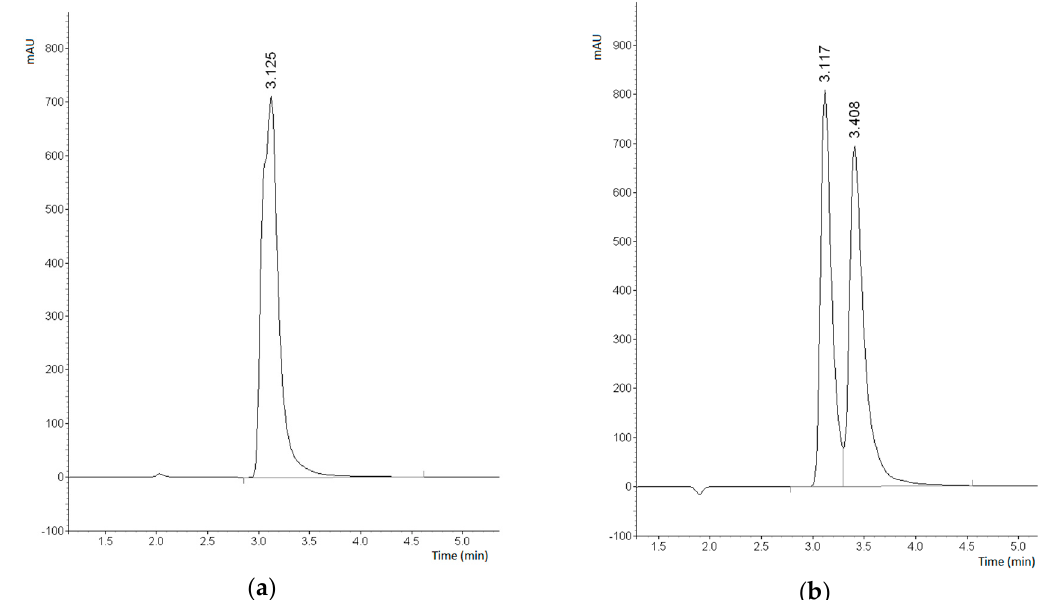
Figure 9. Chromatograms of the separation of flurbiprofen on CSP-10 using mobile phase: hexane-2-propanol-CH 3 COOH = 90:10:0.1 ( a ) and hexane-2-propanol = 80:20 + 1 g dm − 3 NH 4 OAc ( b ).